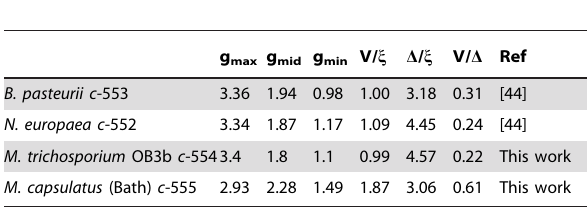
Table 1. Ligand field and g-tensor values for the EPR signal from the c -type cytochromes (EPR spectra shown in Figure